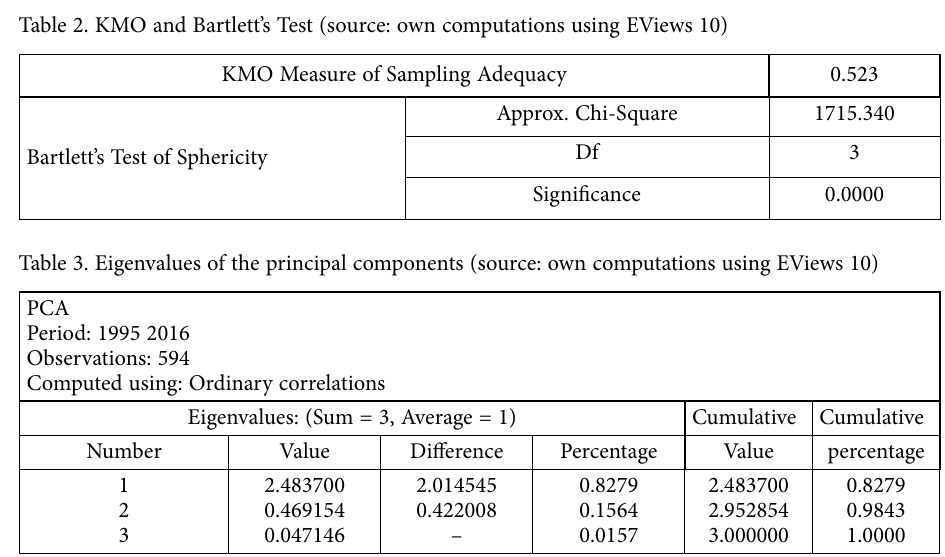
Table 2. KMO and Bartlett’s Test (source: own computations using EViews 10) KMO Measure of Sampling Adequacy